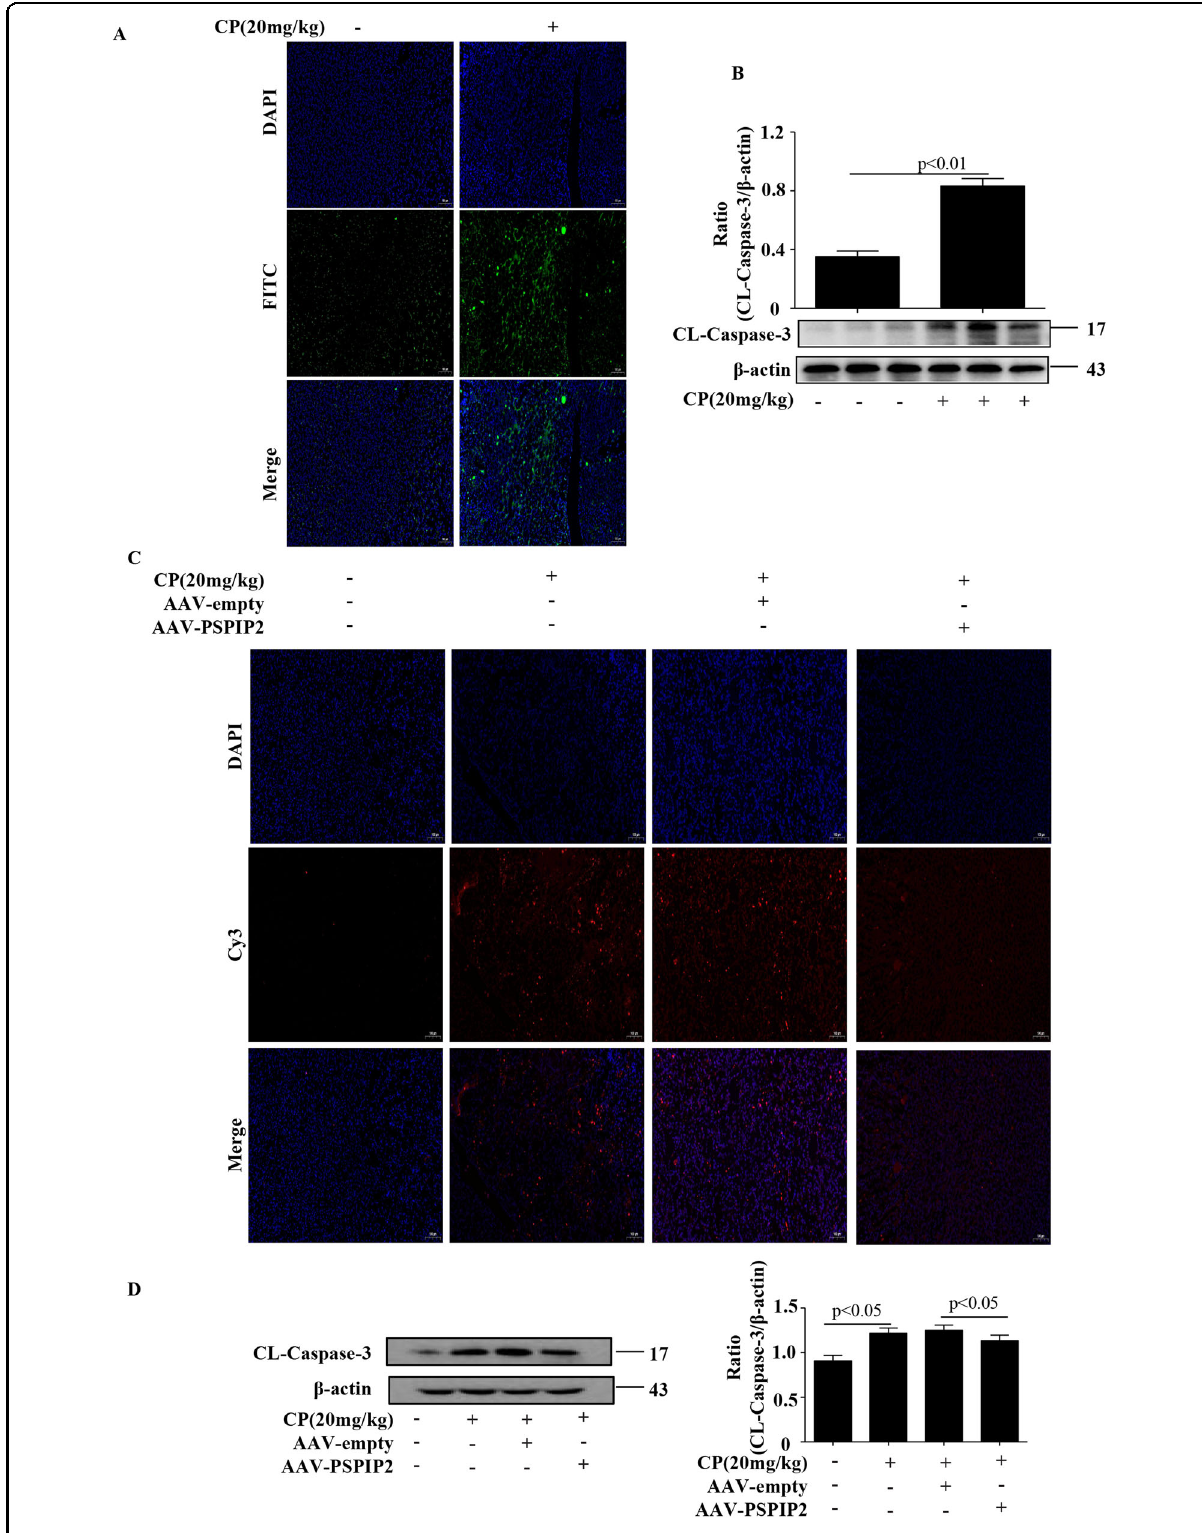
Fig. 4 PSTPIP2 suppressed CP-induced kidney apoptosis in vivo. a Representative images of TUNEL staining in various groups. Scale bar, 100 μ M; magni fi cation, 10×. b The cleaved caspase-3 protein levels in the kidney tissue analysed by western blot. c Representative images of TUNEL staining in various groups. Scale bar, 100 μ M; magni fi cation, 10×. d The cleaved caspase-3 protein levels in various groups analysed by western blot. Similar results were obtained in 3 independent experiments with 10 mice per